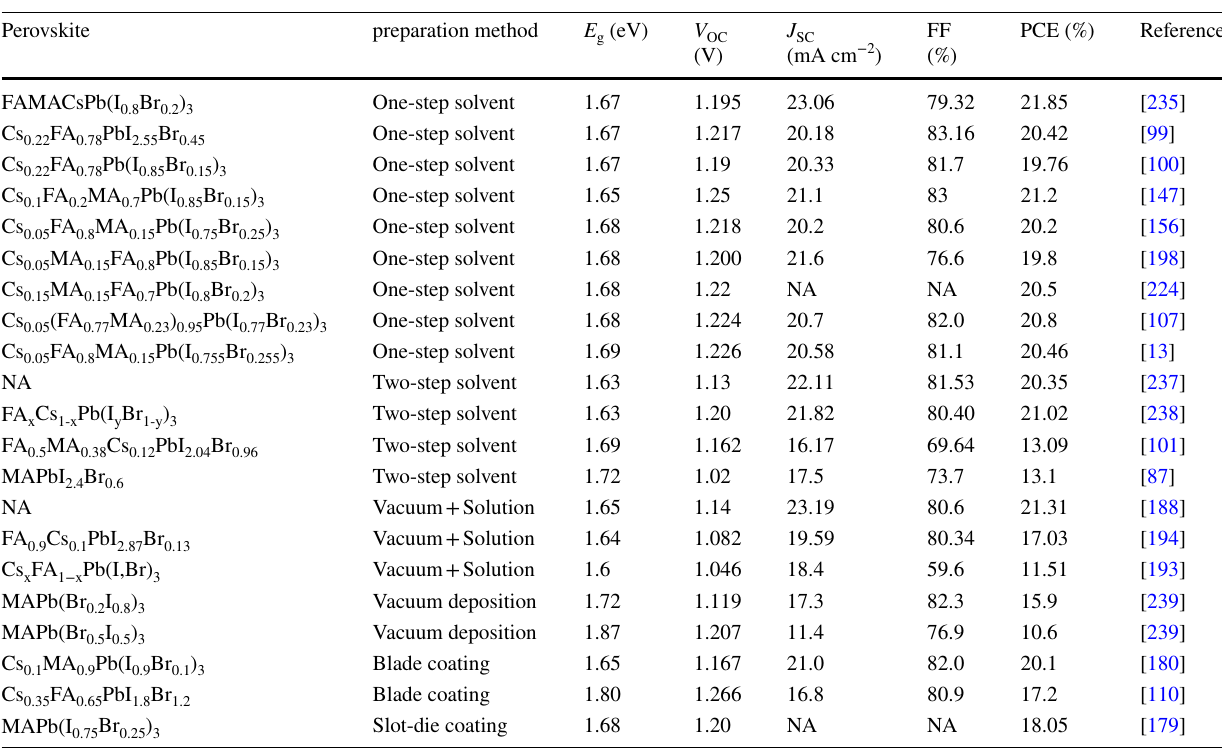
Table 6 Summary of WBG PSCs with representative preparation method